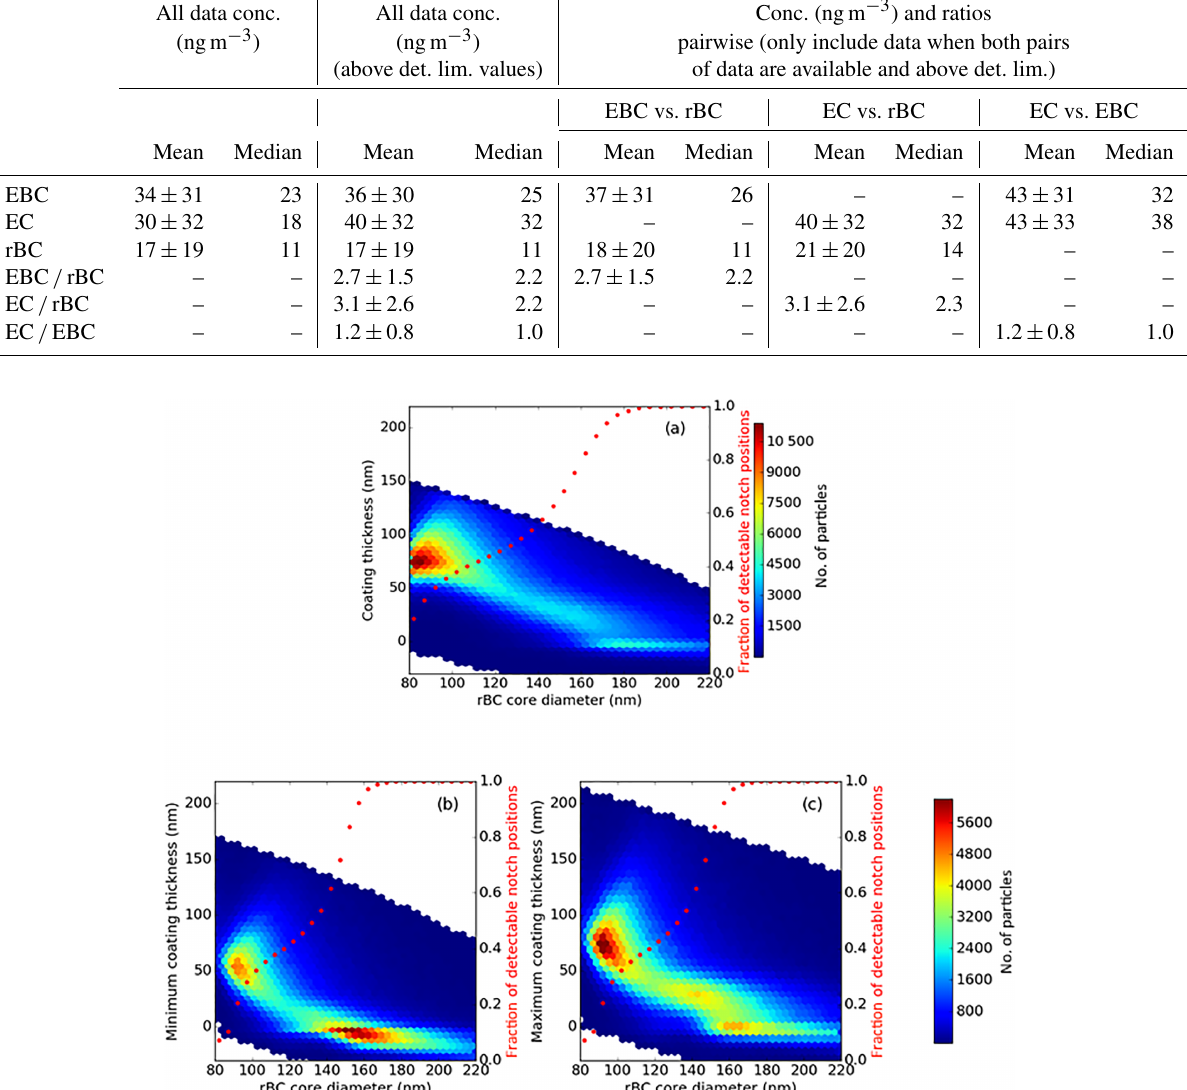
Table 3. Statistical parameters such as mean, median, and standard deviation for all data, March 2011 to December 2013, and data with only above detection limit values included. The ratios are only meaningful for the data above the detection limit values. Also pairwise statistics available for dataset when both pairs in comparison had data. In the comparison to Table 2, where all data including negative values are used in the regression analyses, Table 3 values in the first column labeled “All data conc.” include negative values and are more comparable. All data conc.